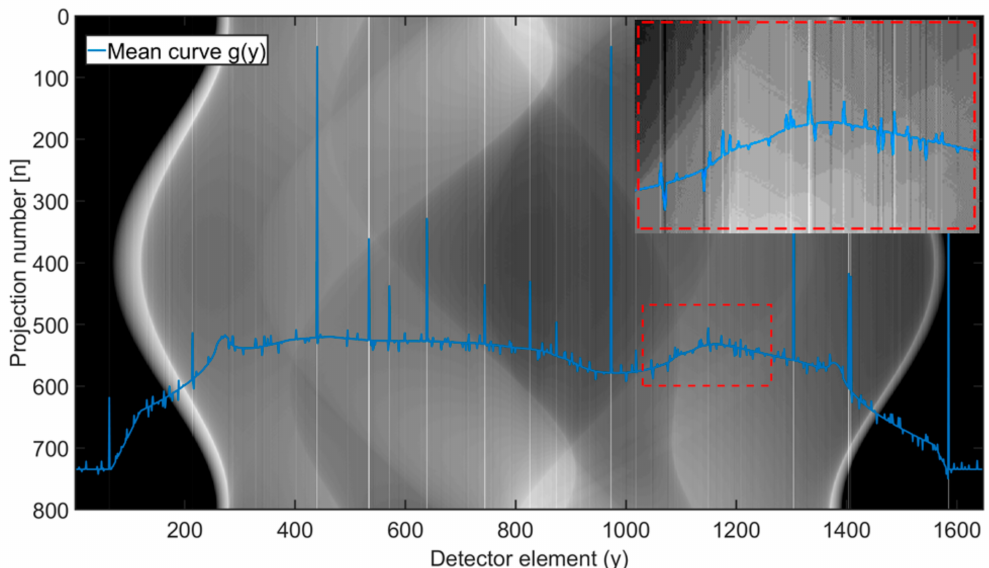
Figure 6. Shepp-Logan phantom sinogram affected by simulated ring artifacts presented in Figure 5. Blue curve shows mean column values—the highest peaks belong to high-level ring artifacts (HRA). In the red labelled image, the magnified area affected by low-level ring artifacts (LRA) is